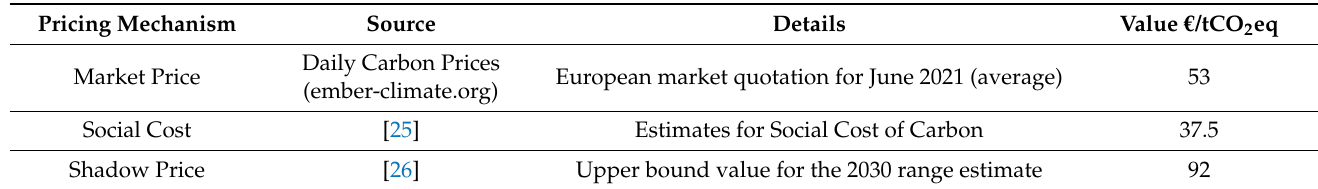
Table 1. Carbon price estimates based on different explicit carbon pricing mechanisms